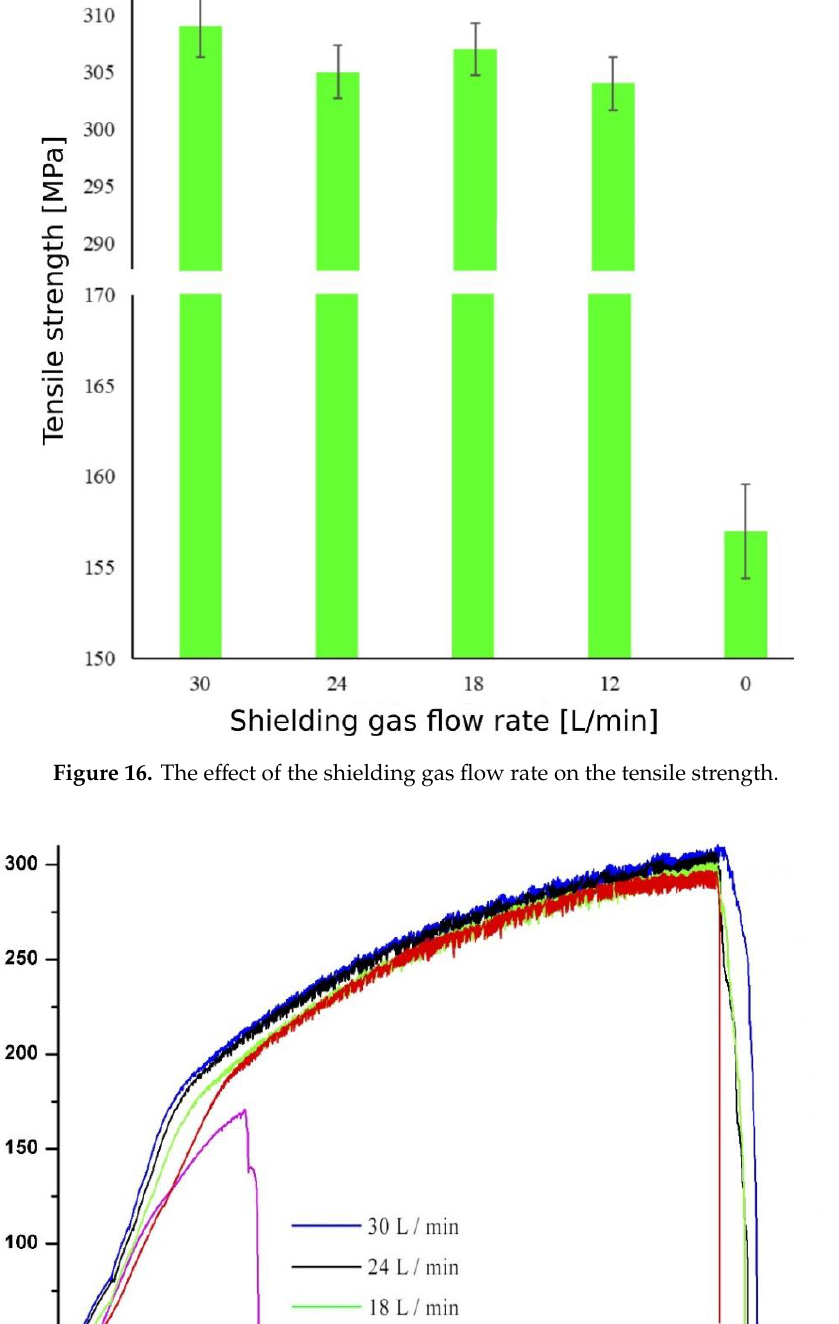
Figure 15. A schematic of the tensile test specimen.